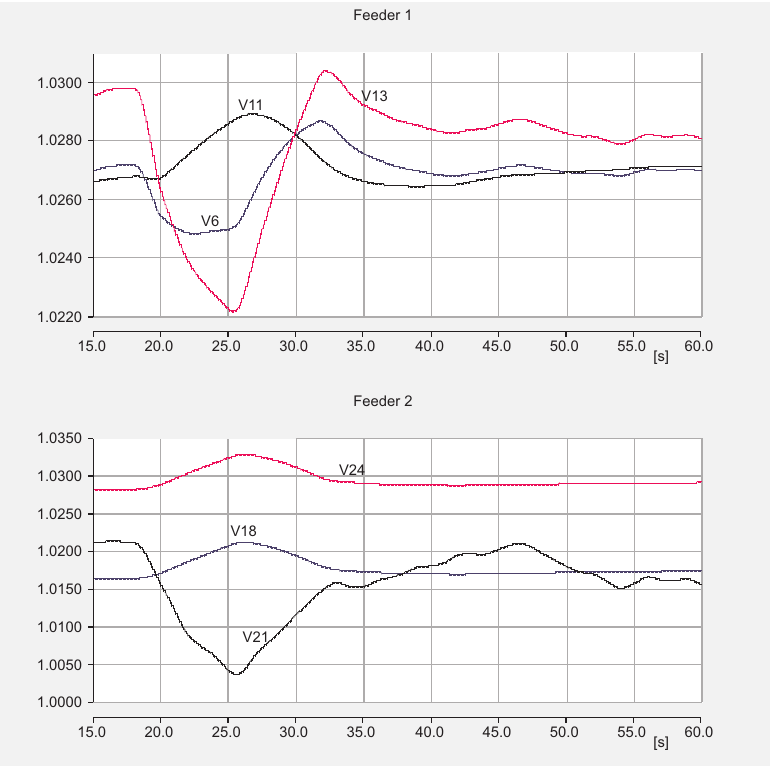
Figure 8. Time evolution of the voltages in the presence of variation in the wind